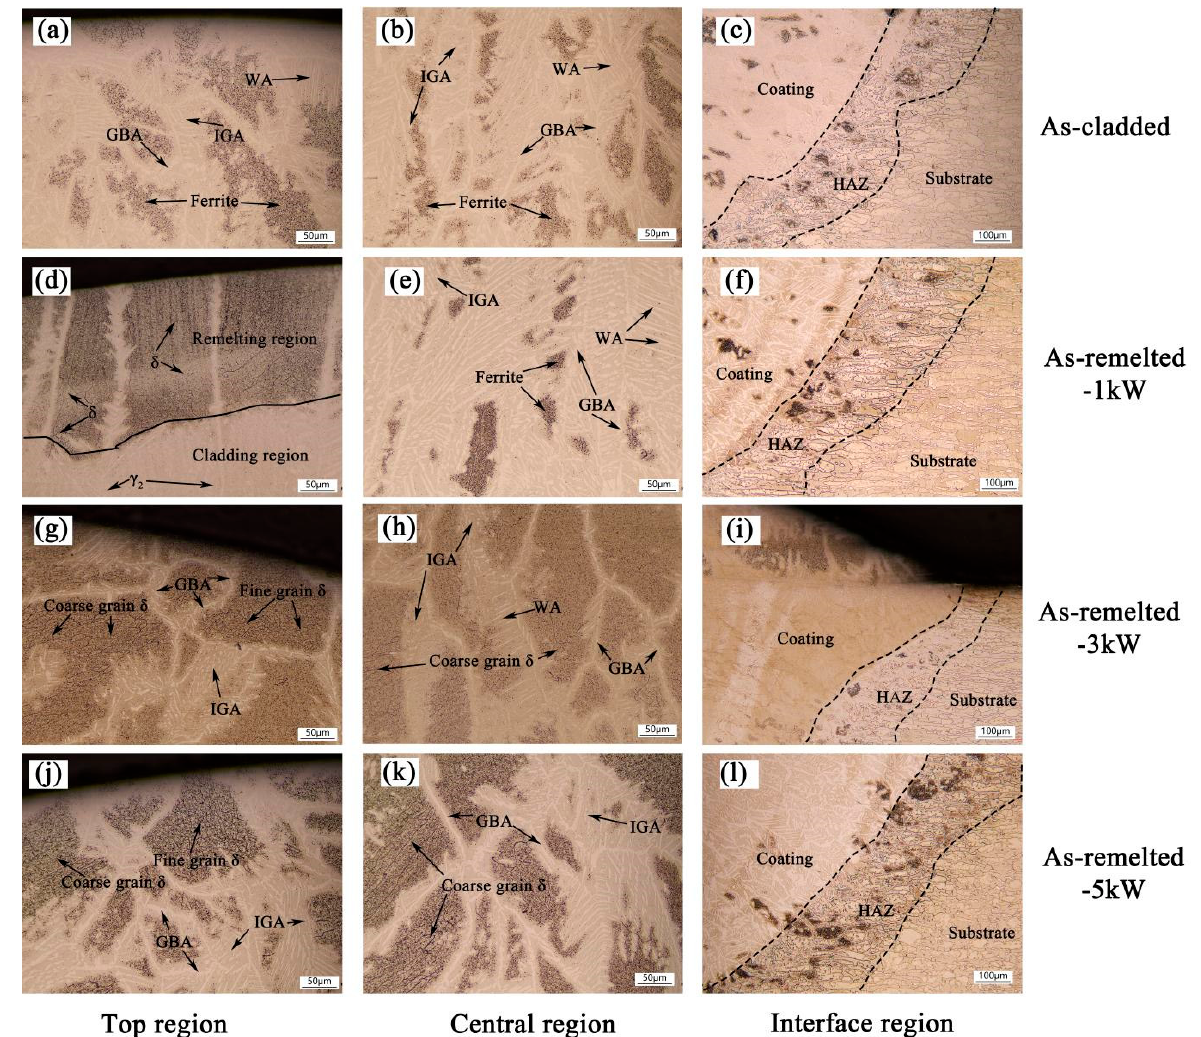
Figure 6. OM images of as-cladded and as-remelted coatings: ( a ) at the top region, ( b ) at the central region and ( c ) at the interface region of as-cladding DSS coating; ( d ) at the top region, ( e ) at the central region and ( f ) at the interface region of as-remelted-1 kW DSS coating; ( g ) at the top region, ( h ) at the central region and ( i ) at the interface region of as-remelted-3 kW DSS coating; ( j ) at the top region, ( k ) at the central region and ( l ) at the interface region of as-remelted-5 kW DSS coating.